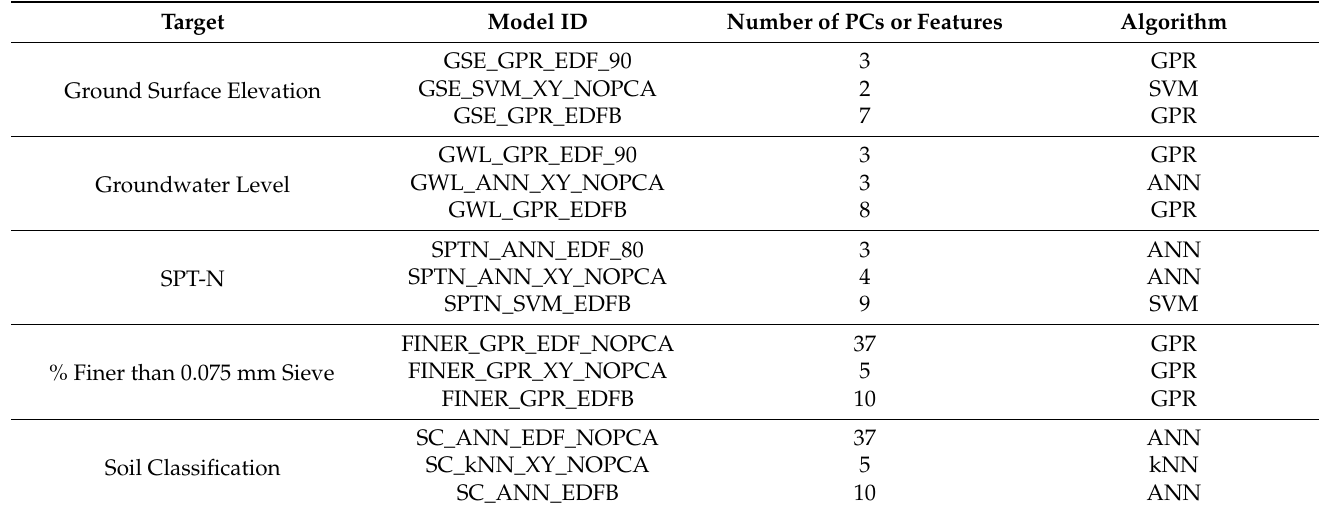
Table 4. Best-performing machine learning models and algorithm with EDF, XY, and EDFB approach for predicting each target based on RMSE error score and prediction accuracy.